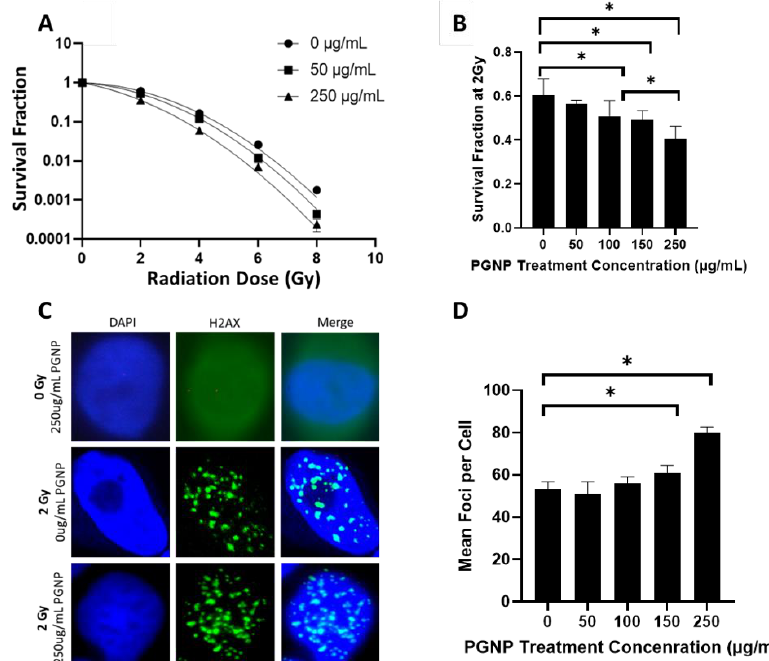
Figure 2. ( A ) Representative survival curve for LNCaP cells irradiated with various doses (0, 2, 4, 6, 8 Gy) following a 24 h pretreatment of PGNPs at different concentrations. ( B ) Survival fraction of 2 Gy-irradiated LNCaP cells, 24 h after the treatment with PGNPs at different concentrations. ( C ) γ-H2AX staining of LNCaP cells pretreated with 0 or 250 µg/mL PGNPs and irradiated with 0 Gy or 2 Gy. ( D ) Comparison of γ-H2AX foci counts for groups with different PGNP concentrations after 2Gy irradiation. * Denotes p < 0.05 from Welch’s t-test.